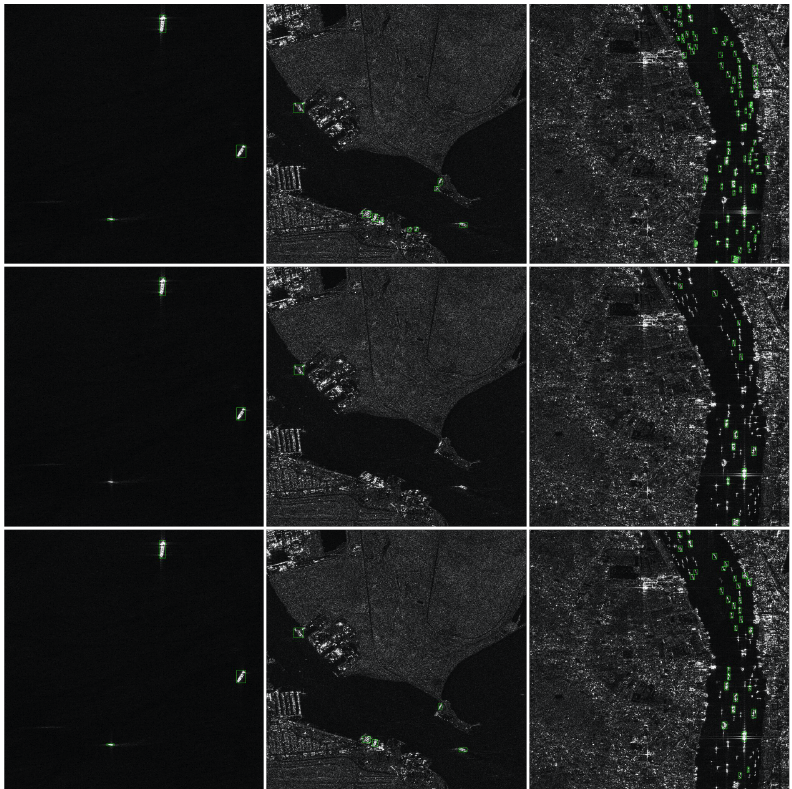
Figure 13. Comparison diagram of FCOS and AFE detection